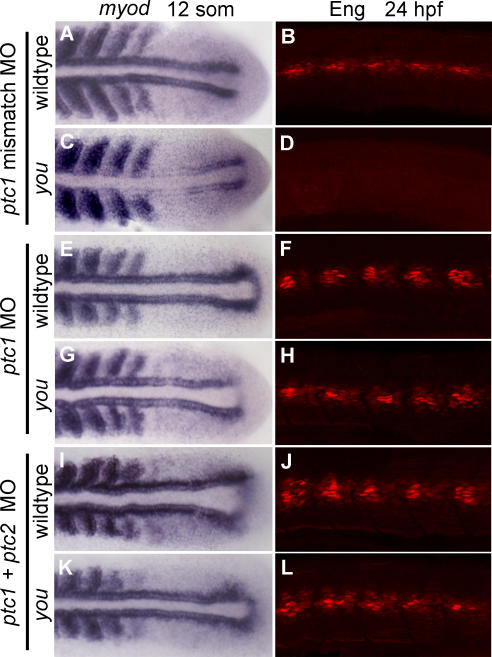
Knockdown of patched Function Rescues Slow Muscle Defects in you
After injection of 420 pg of a mismatch control ptc1 MO, adaxial expression of myod (A) and Engrailed (B) was normal in wild-type embryos, but absent in you mutant embryos (C and D). When injected with 420 pg of a MO targeting ptc1, however, myod expression in mutants (E) was rescued to levels comparable to wild-type embryos (G). Engrailed expression was slightly expanded in both wild-type (F) and mutant (H) embryos injected with 420 pg of ptc1 MOs. Both adaxial myod expression and Engrailed expression was slightly expanded in wild-type (I and J) and you mutant embryos (K and L) injected with MOs targeting both ptc1 and ptc2 (420 pg each). Embryos assayed for myod expression are shown in flat mount at the 12-somite stage, and somites 5–9 of Engrailed-expressing embryos are shown in lateral view at 24 hpf. Anterior is to the left in all panels. Genotypes of all embryos were determined by PCR after photography.